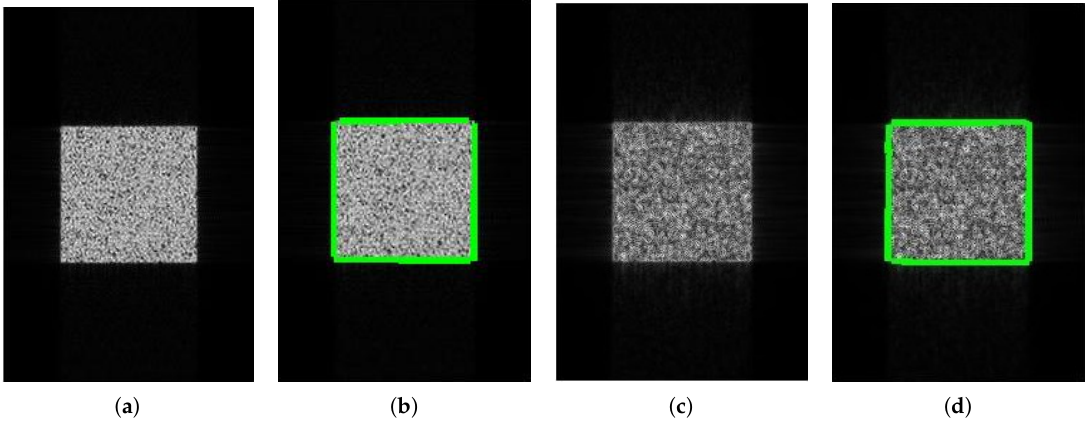
Figure 5. The imaging and edge detection result for the rectangular area. ( a ) Original image; ( b ) edge detection result of the original image; ( c ) edge-enhanced SAR image; ( d ) edge detection result of the edge-enhanced SAR image.